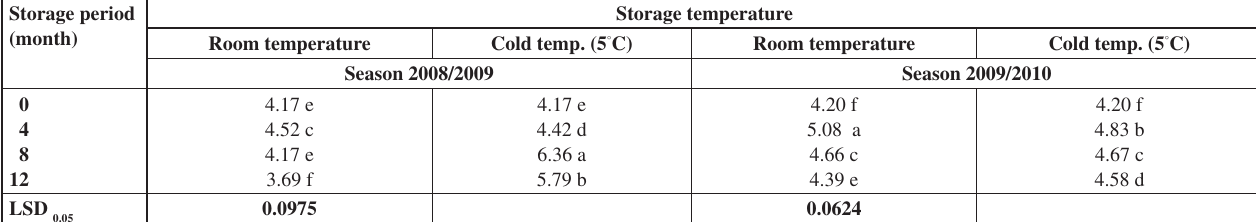
Table 11: Effect of the interaction between storage temperature and storage period on water content (%) of onion seeds during seasons of 2008/2009 Storage period